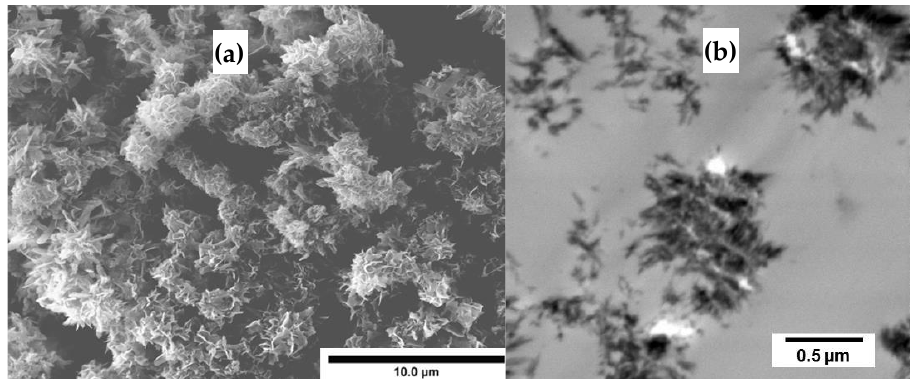
Figure 13. Calcium phosphate coating obtained by pulsed current electrodeposition. ( a ) SEM image and ( b ) TEM image. Reprinted with permission from Ref. [74]. Copyright 2011 Springer US.